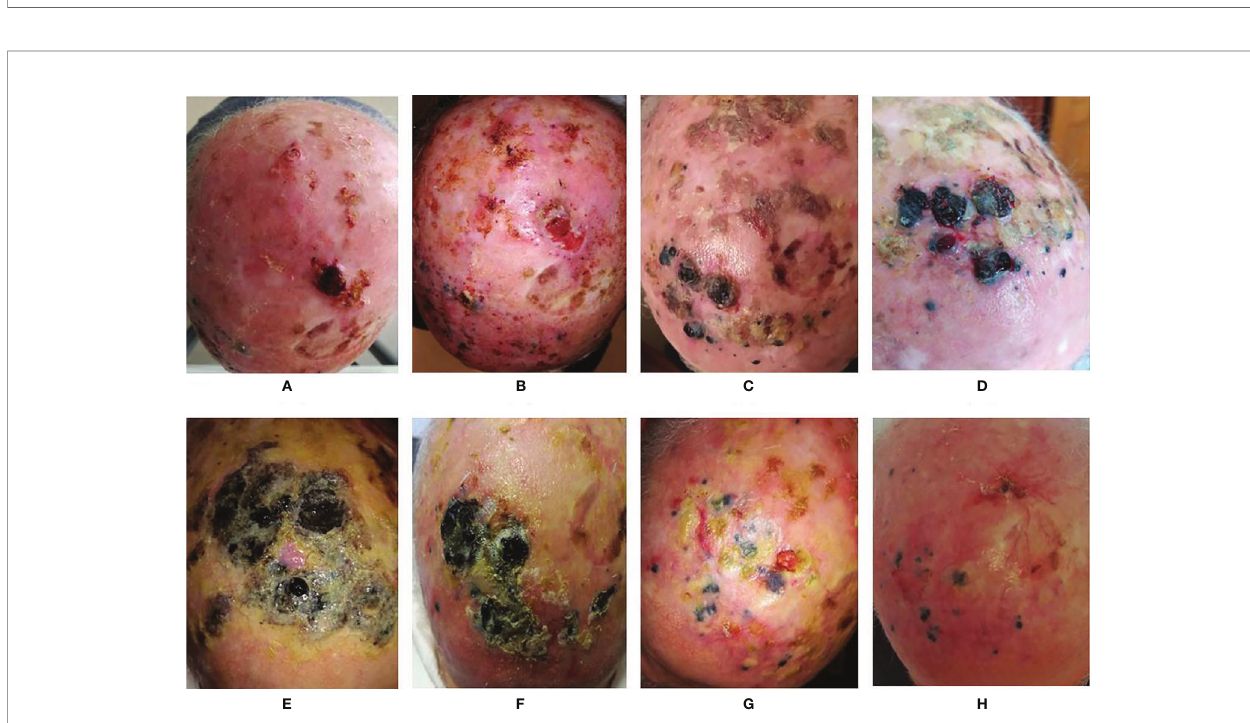
FIGURE 2 | Evolution of the lesions. (A) Basal evaluation; (B) 2 weeks after the fi rst ECT; (C) 2 months after the fi rst ECT and 1 month after 1 cycle of anti-PD1; (D) 3 months after the fi rst ECT and 1 month after 2 cycles of anti-PD1; (E) 1 week after the second ECT; (F) 2 months after second ECT and completion of 5 cycles of anti-PD1; (G) 3 months after second ECT and anti-PD1 temporary suspension for toxicity; (H) 17 months after the second ECT and after 15 cycles of